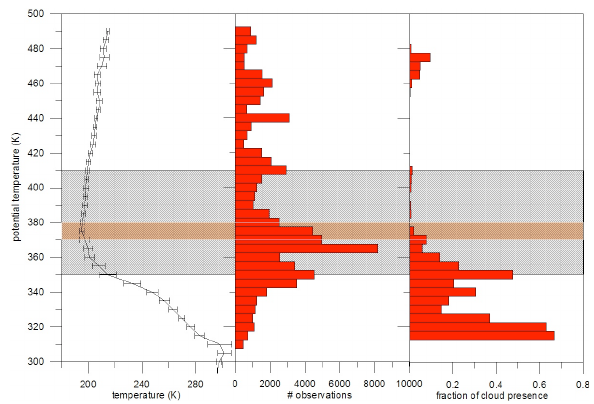
Figure 2. Left panel: temperature versus potential temperature as measured along the M55 flights between 1–16 August 2006. Only data southward of 17.5 ◦ N were used to calculate averages. Bars denote one standard deviation. Middle panel: total number of observations in seconds spent at a given theta level versus potential temperature. Right panel: fraction of observations in cloudy (hazy) air, defined as air masses with Volume Backscatter Ratio > 1.2. Grey shading denotes main TTL region and brown shading the tropopause. See text for details.